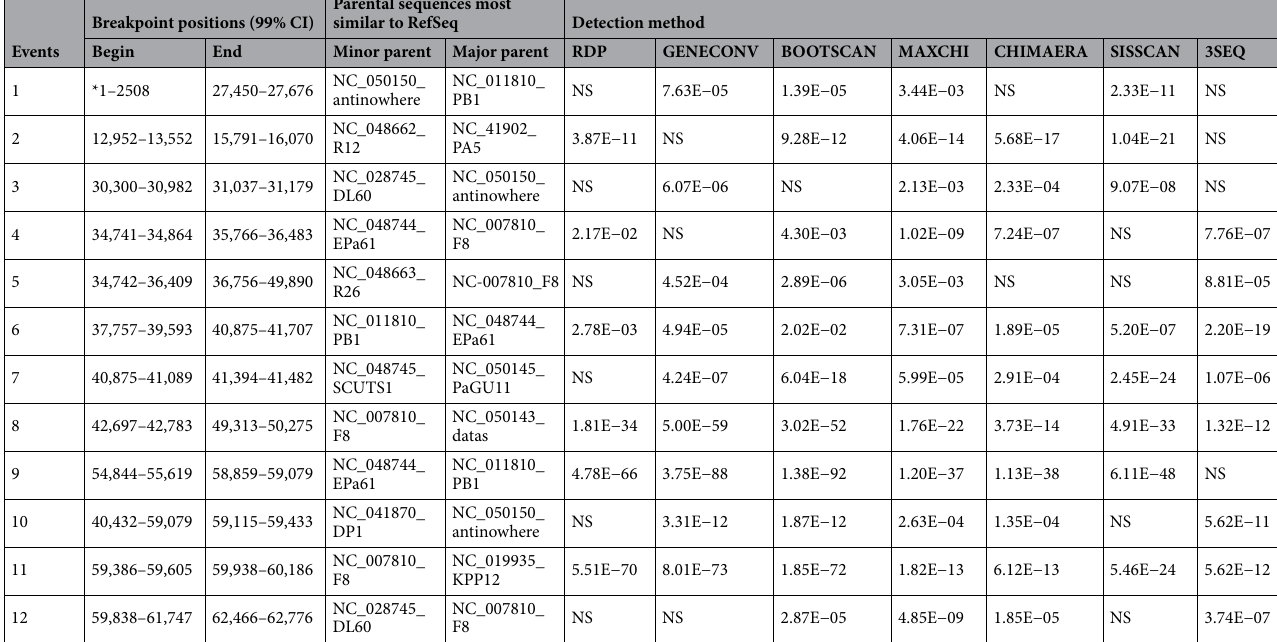
Table 2. Details of recombination events detected in the DRL-P1 complete genome. NS not significant.